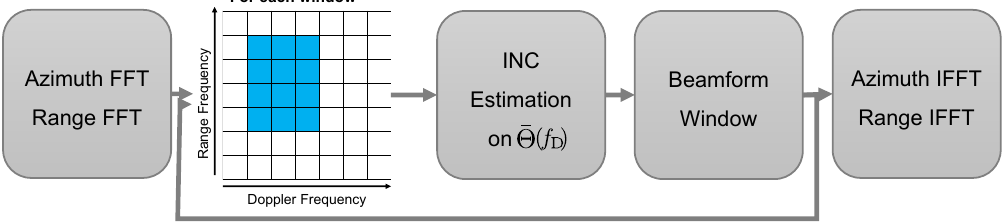
Figure 13. Doppler-Dependent Frequency MVDR RFI mitigation with DBF. A mitigation of M − 1 interferers per window is